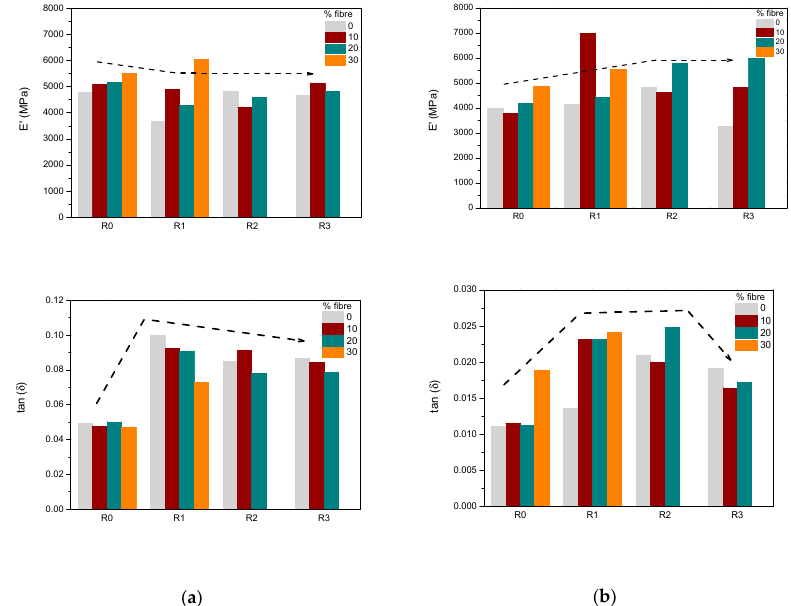
Figure 8. Comparison of the storage modulus ( E’ ) and of the loss factor ( tan δ ) for PHBV ( a ) and PLA biocomposites ( b ), before recycle (R0) and at different recycles steps (R1, R2 and R3). (Standard deviation for E’: ±200 MPa for reinforced samples and ±25 MPa for pristine samples).